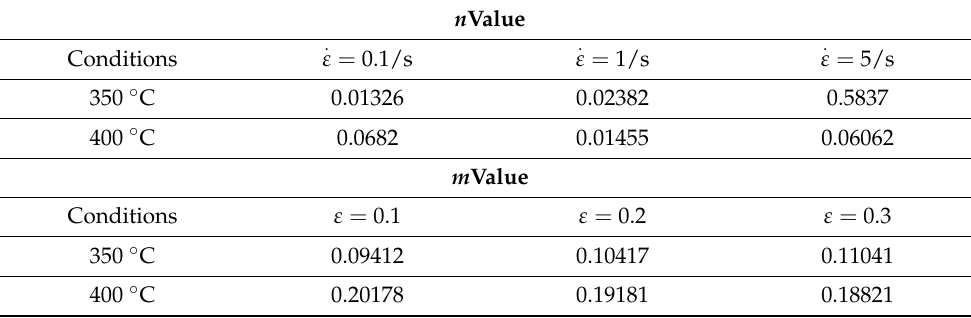
Table 5. The determined n and m values for the FB phenomenological model.